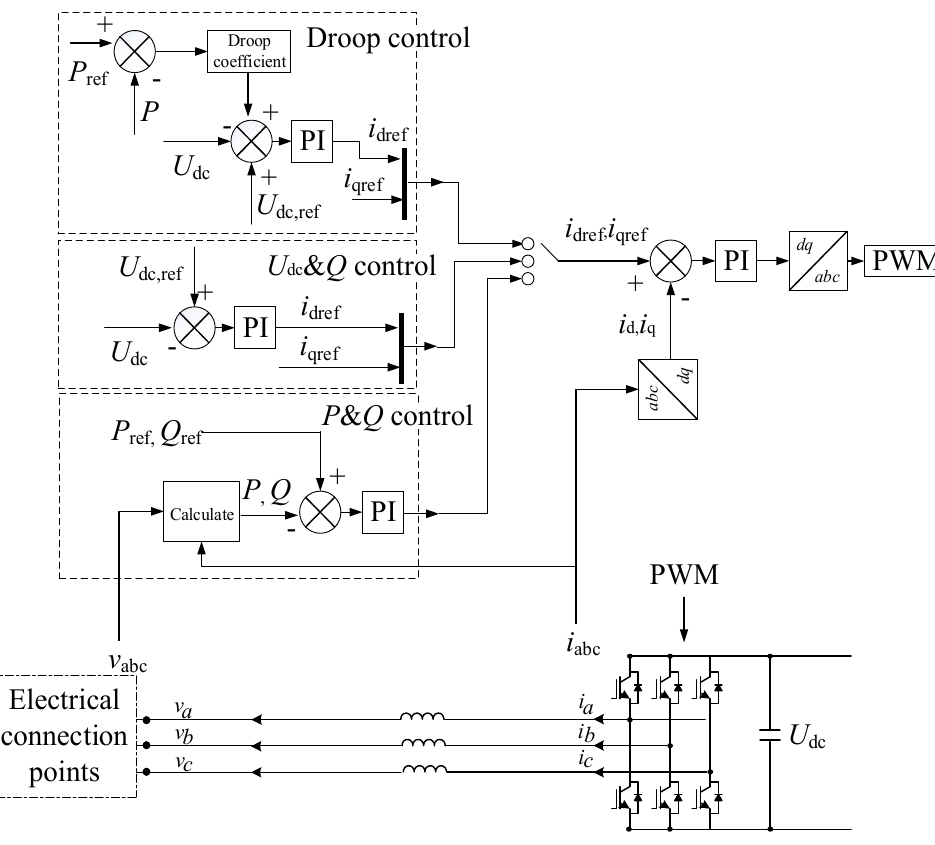
Figure 2. Typical control strategies of utility-interfacing voltage-source converter (VSC).